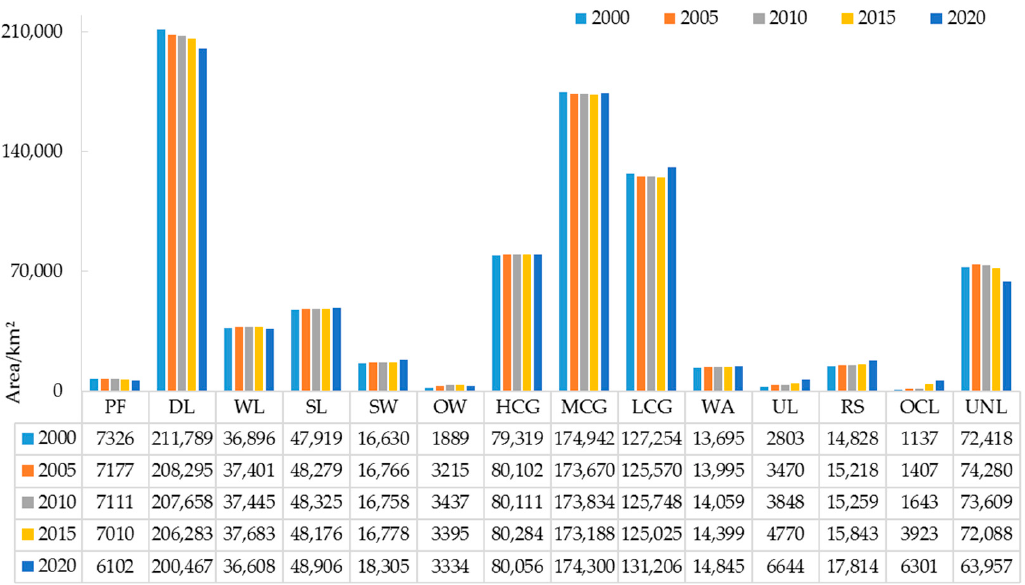
Figure 3. Land use change in the Yellow River Basin in 2000, 2005, 2010, 2015, and 2020. From 2000 to 2020, the stable intensity of land types, in order from high to low, are urban land, rural settlements, woodland, dry land, paddy field, unused land, high-coverage grassland, middle-coverage grassland, low-coverage grassland, other construction land, shrub land, water, sparse woodland, and other woodland (Table 7). In 2020, 85.8% of urban land remained unchanged, and different land types were converted to urban land in different degrees, among which dryland had the largest inflow area of 2425 km 2 . Only 17.84% of other forest land remained unchanged, and the rest was converted to other land use types, with the most significant proportion converted to dryland at 35.31%. Table 7. Land use transfer matrix of the Yellow River Basin between 2000 to 2020 (%).